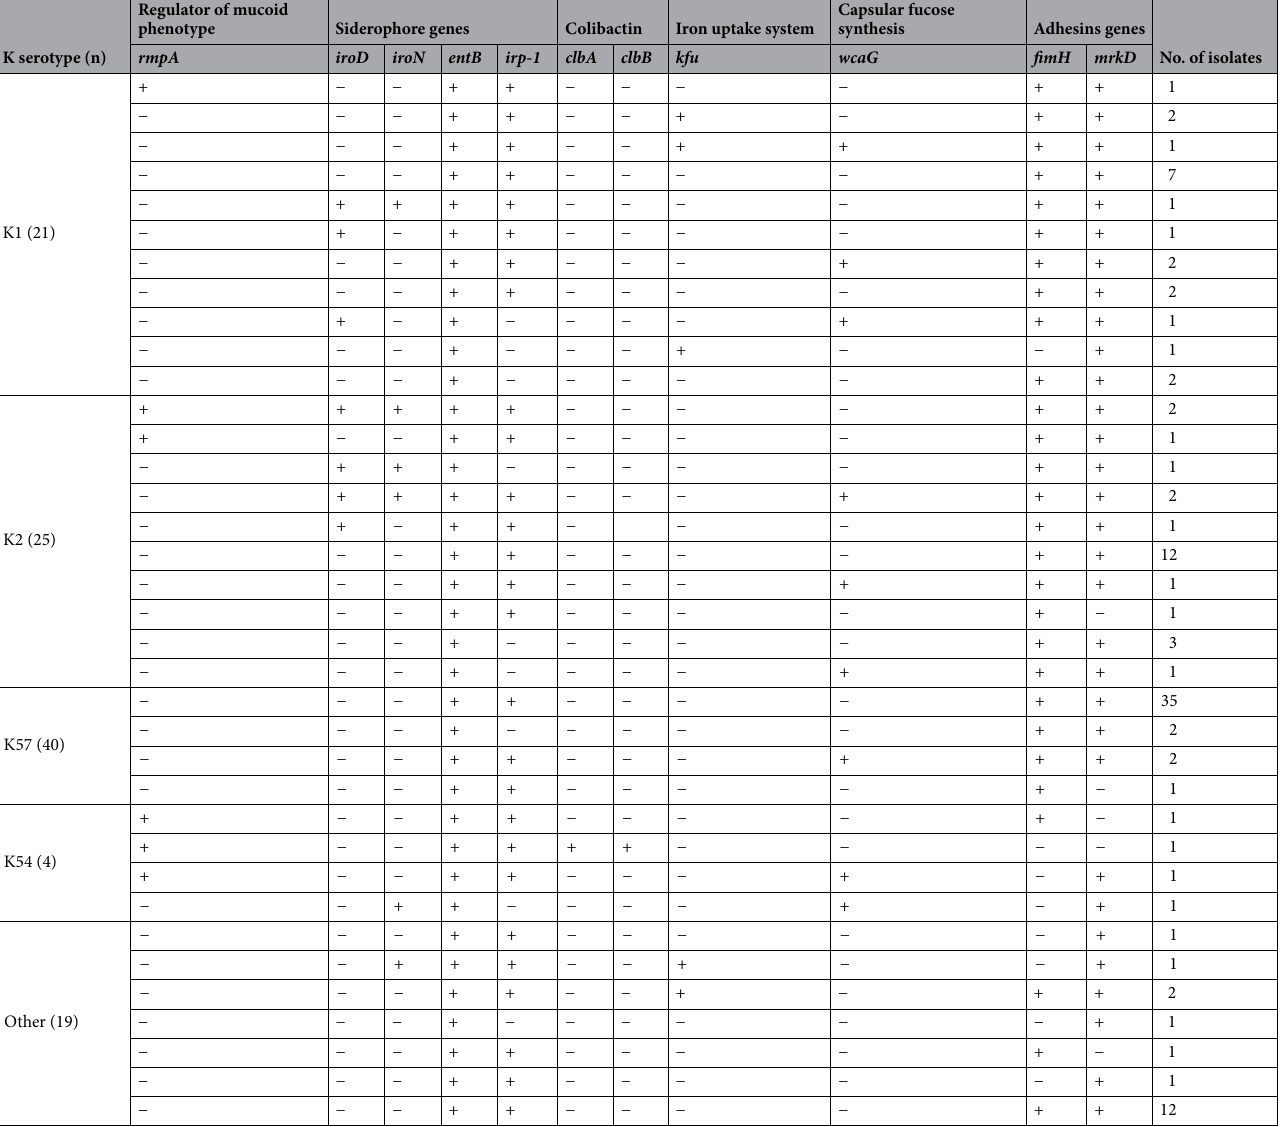
Table 5. Distribution of virulence-associated genes among K serotypes of K. pneumoniae.